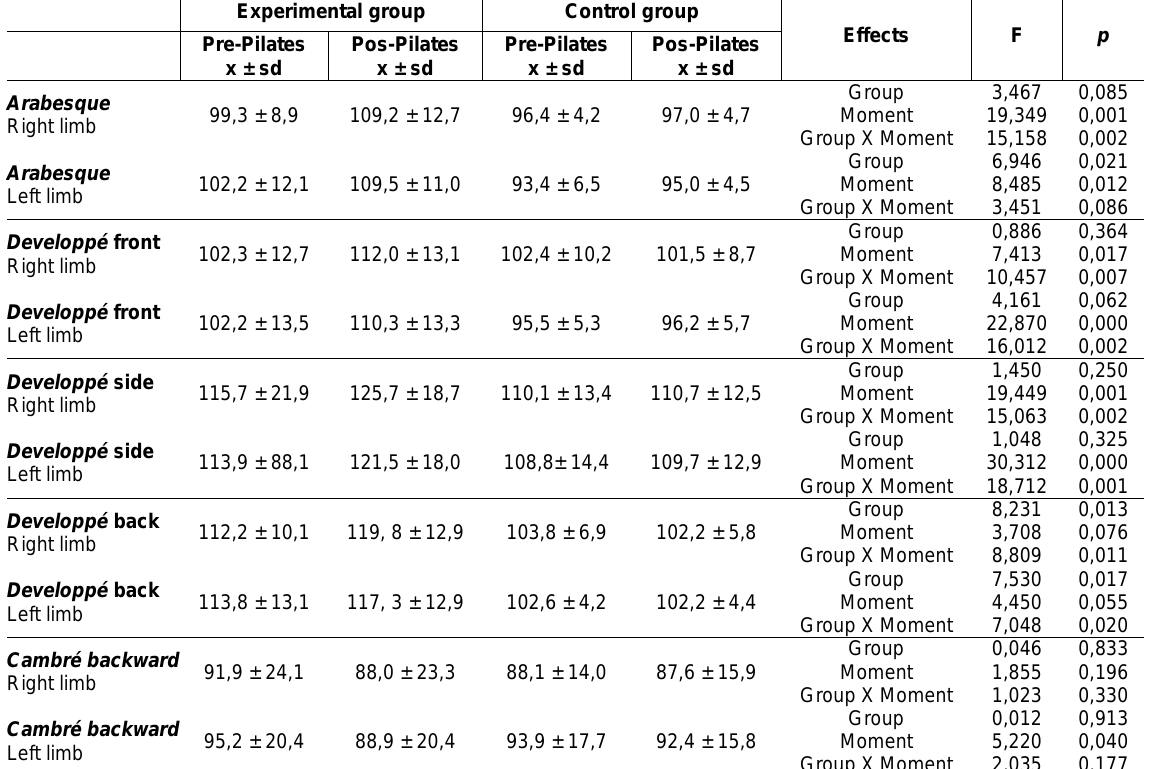
Table 2. Flexibility measures (degrees) pre and post-Pilates